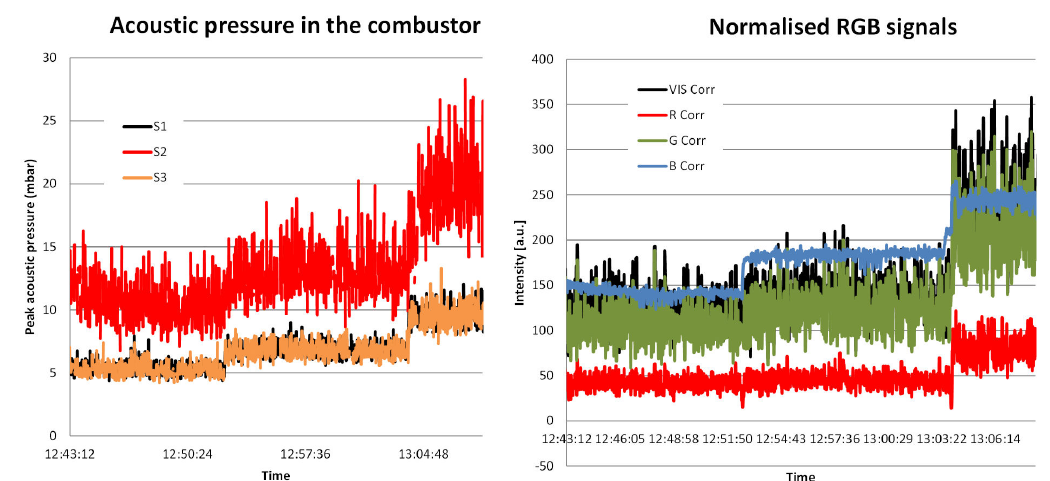
Figure 21. Flame monitoring from 4.25 kW via 5.1 kW to 5.95 kW at 1.4 bar abs: ( left ) sound recorded by three fast pressure probes S1 to S3 and ( right ) the chromatic analysis by